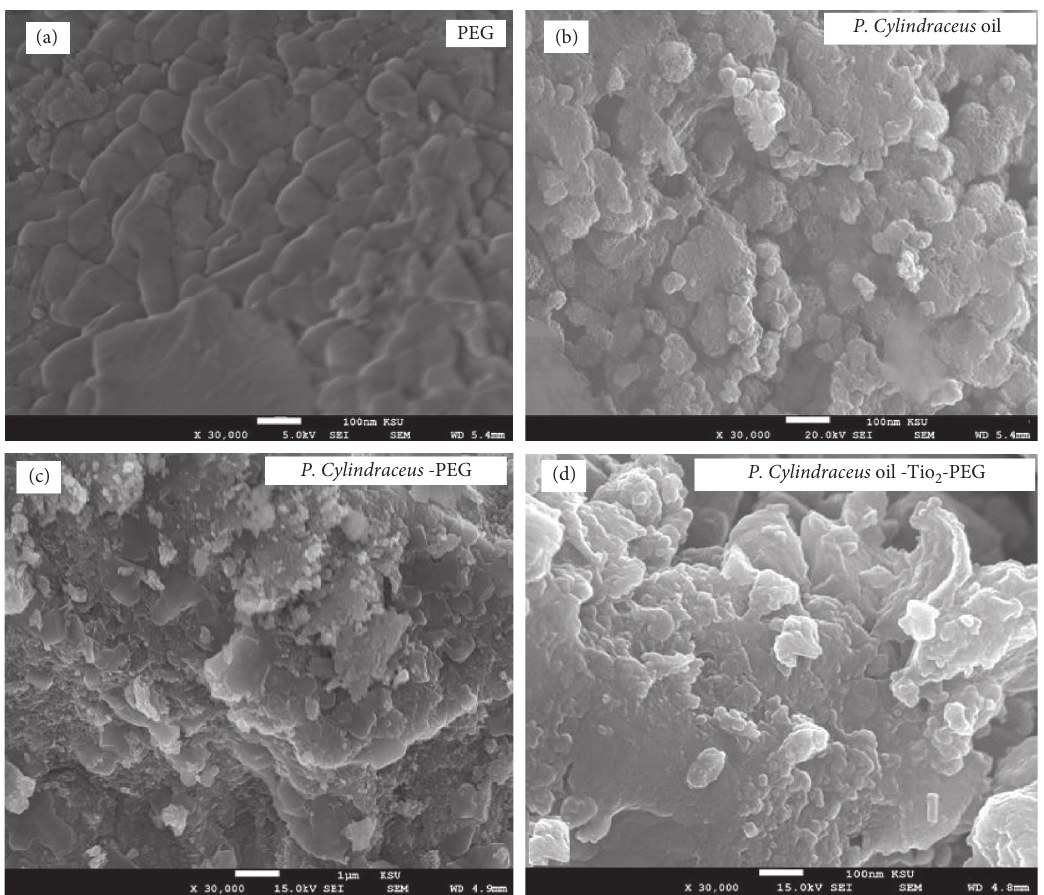
Figure 4: SEM images of (a) PEG, (b) P. cylindraceus oil, (c) P. cylindraceus oil-PEG, and (d) polymeric P. cylindraceus oil-TiO